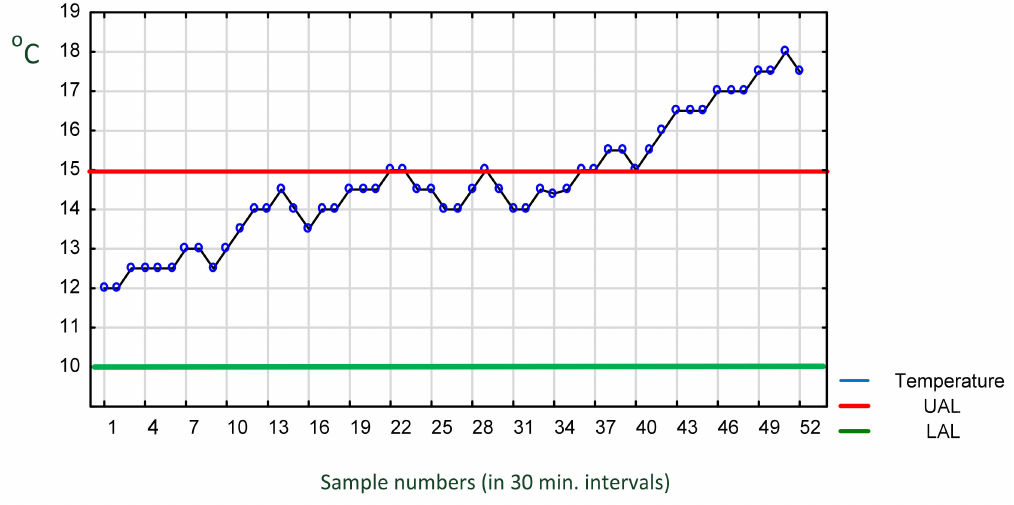
Figure 6. Exemplary record of temperature inside a truck with steadily increasing temperature crossing the upper tolerance. Source: own data collected in 30 min intervals (samples 1–22 daytime driving, 23–37 overnight stop, 37–52 continued driving).